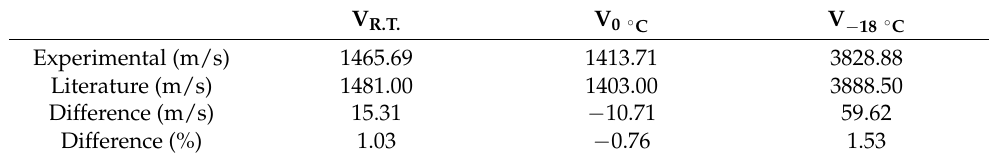
Table 2. Ultrasonic velocity values of this particular experiment compared with literature values [25].